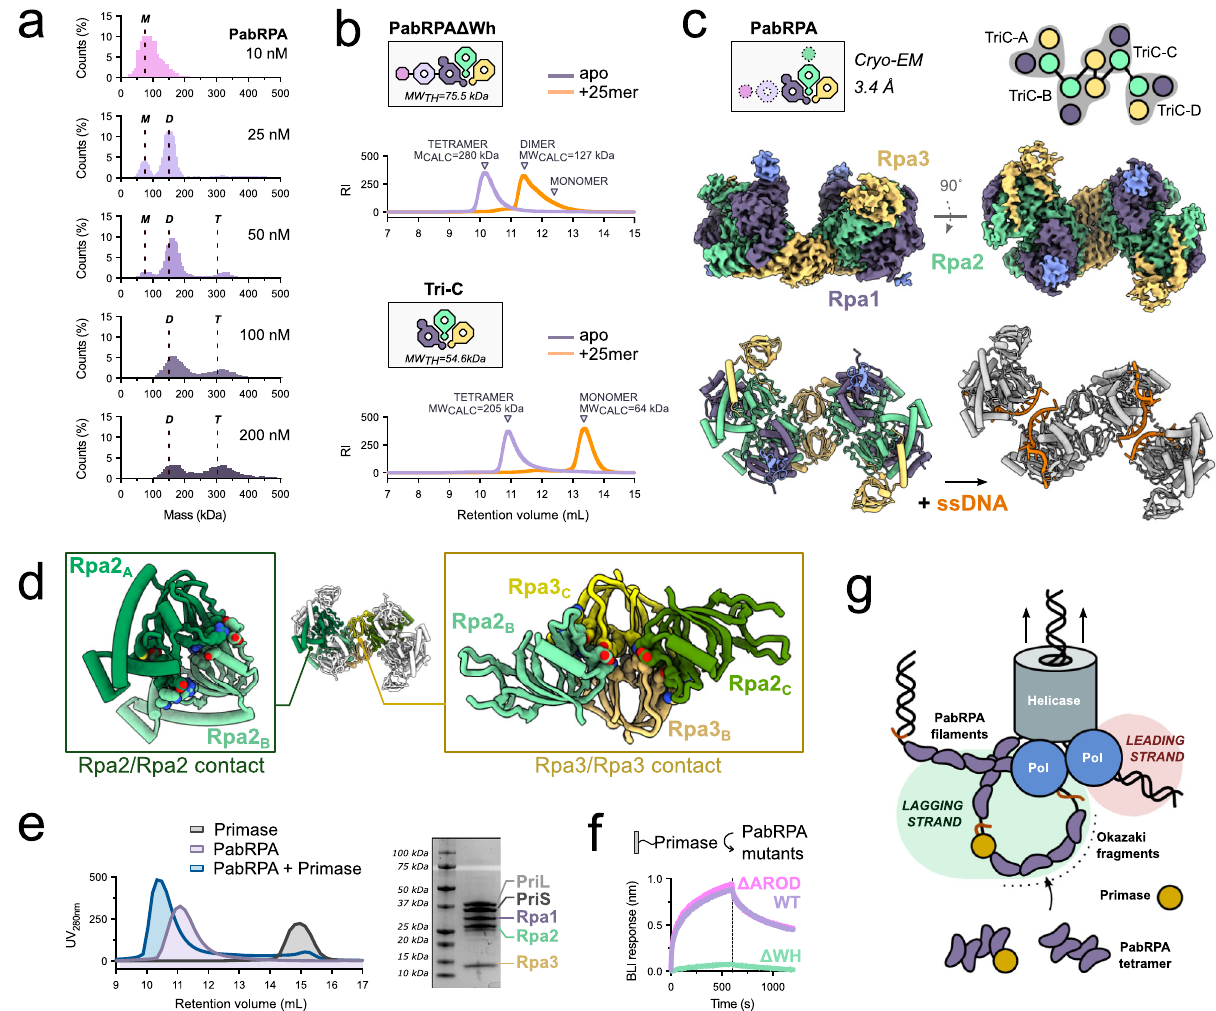
Fig. 4 | PabRPA assemblesasa tetramericsupercomplex thatdissociates upon binding to ssDNA. a Characterization of PabRPA oligomeric states at low con- centrationsbyusingmassphotometry.Expectedmolecularweightsformonomeric (M), dimeric (D), and tetrameric (T) PabRPA supercomplexes are indicated with dotted lines. b SEC-SLS characterization of PabRPA Δ WH and PabRPA Tri-C in the presence or absence of poly-d25T ssDNA. The theoretical (MW th ) and calculated molecular weights (MW calc ) for each complex are given in kDa.PabRPA complexes were injected at 20 µ M. c 3.4Å cryo-EM structure of the tetrameric PabRPA super- structure. d Focused view on critical contacts within the PabRPA tetrameric assembly. e SEC pro fi les of PabRPA, primase, or PabRPA-primase complexes,